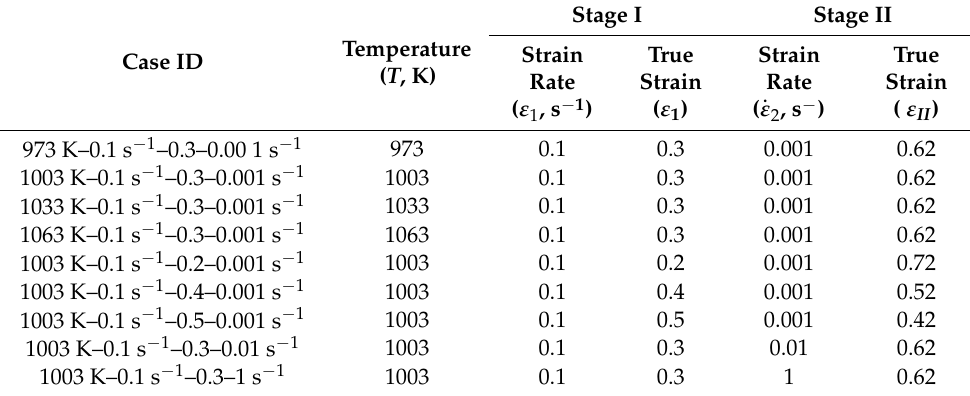
Table 1. Schemes of the hot compression